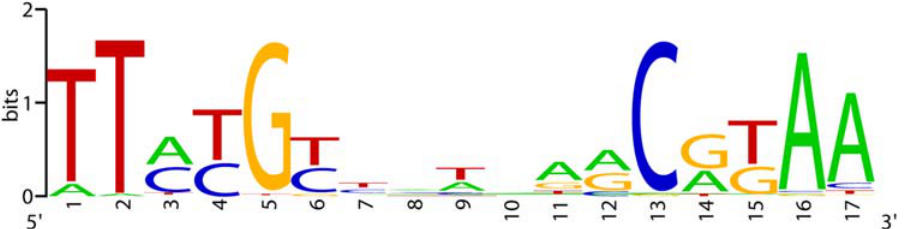
Figure 6. Sequence signature of a predicted site of a radiation response regulator. Four different nucleotides are shown by four letters (A, G, C, T) in different colors. The height of the letter is proportional to its contribution to the information content in the corresponding position of the multiple alignment used for ‘‘sequence logo’’ construction. The figure was constructed by the ‘‘sequence logo’’ program described previously [160].